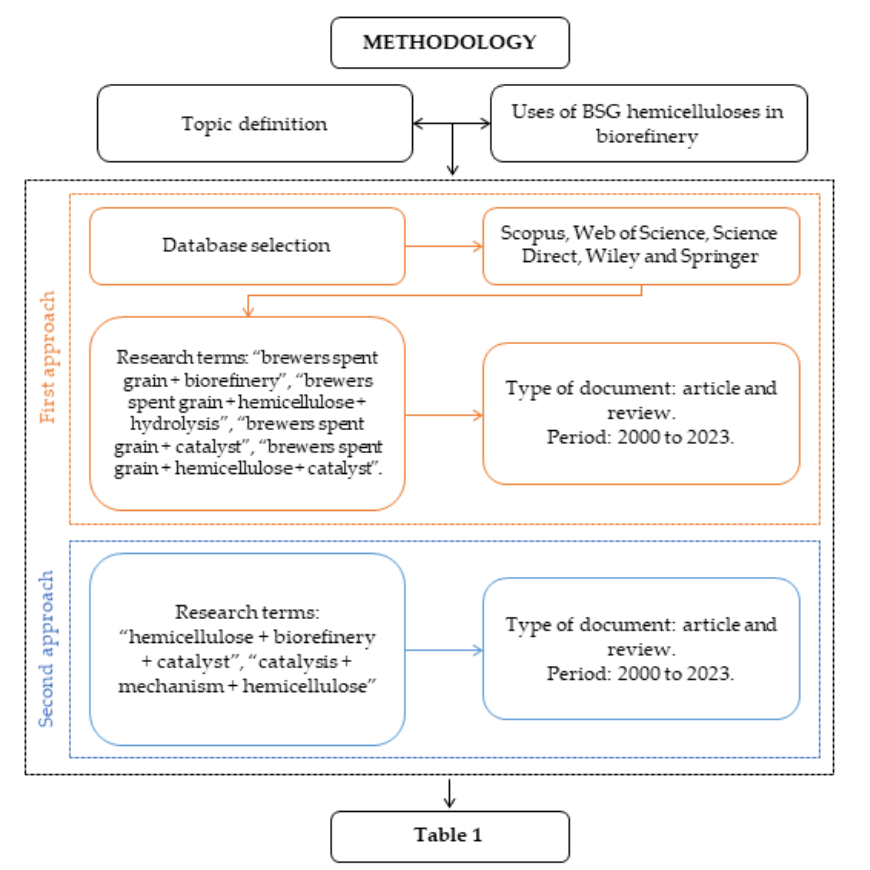
Figure 1. Overview of the methodology used to approach this review. Table 1. Result of the number of articles found in each database with the search terms related to the subject of the